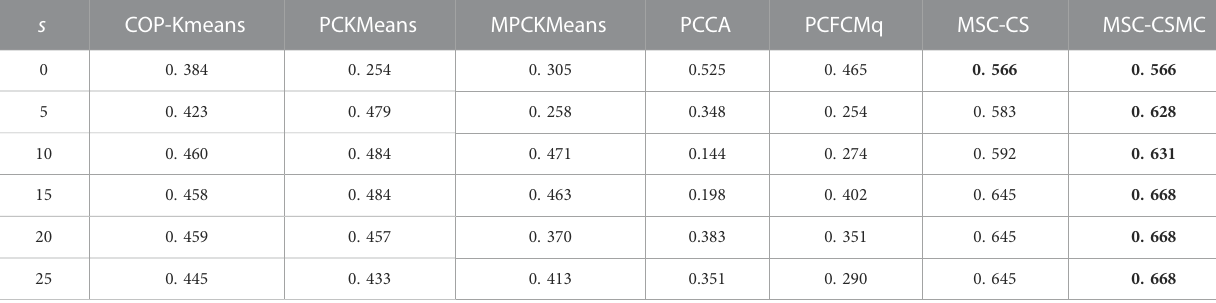
TABLE 3 SI values on Yeast Cell Cycle with different number of constraints.